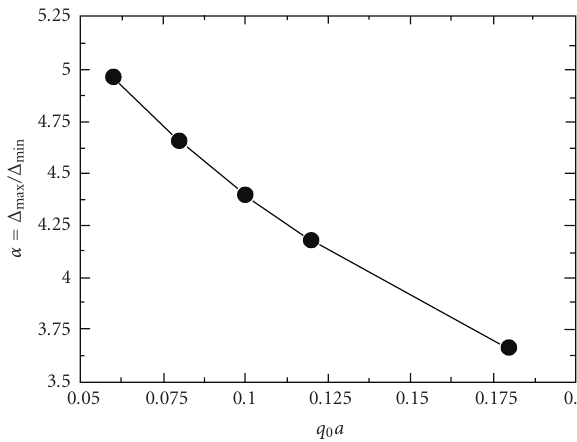
Figure 10: The anisotropy ratio α = Δ max / Δ min versus the screening parameter q 0 a .